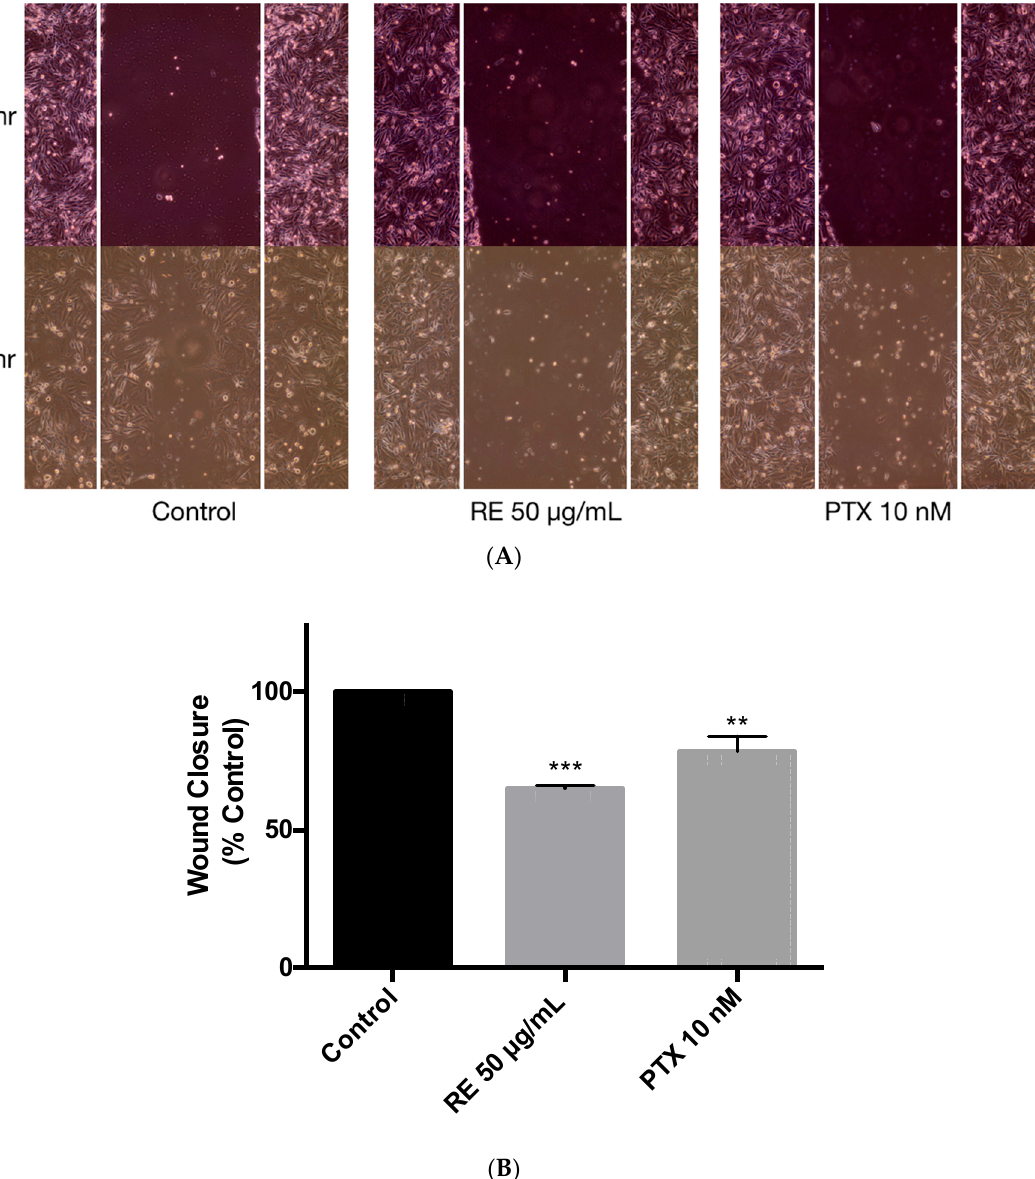
Figure 7. Effect of rosemary extract on MDA-MB-231 breast cancer cell migration. MDA-MB-231 cells were exposed to 1 µg/mL of mitomycin-C for one hour, followed by treatment with or without 50 µg/mL rosemary extract (RE) or 10 nM paclitaxel (PTX) for 40 h. Representative images of wound healing are shown immediately after being scratched with a 200 µL pipette tip (0 h) and after 40 h of treatment ( A ). Wound closure was calculated as indicated in the methods and expressed as a percent of control untreated cells ( B ). The data are the mean ± SEM of three independent experiments. ** p < 0.01, *** p < 0.001.